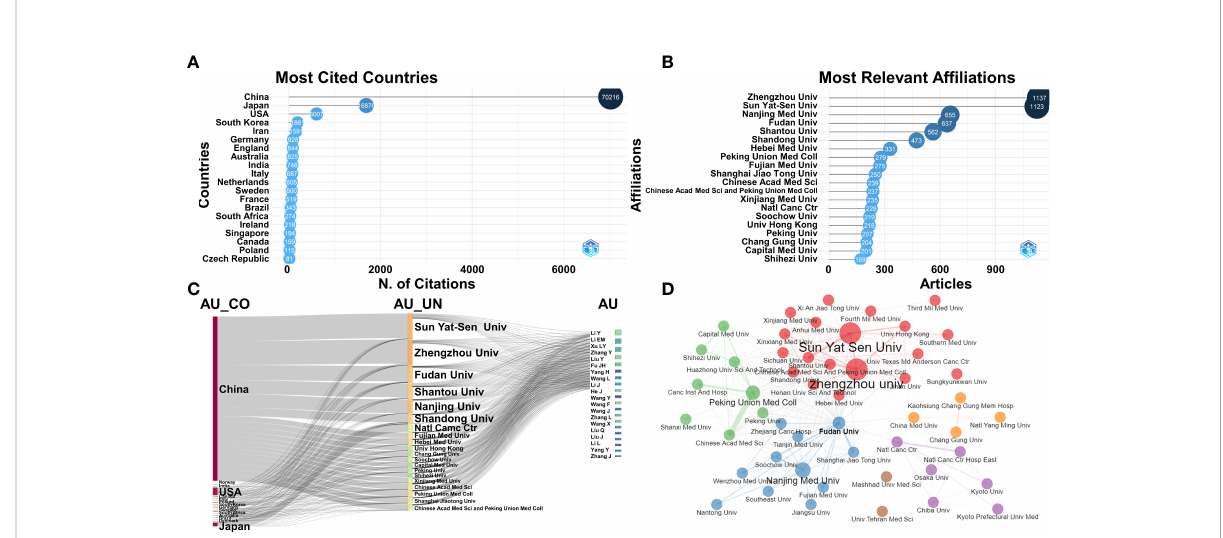
FIGURE 4 (A) Top 20 countries with the most global citations. (B) Top 20 institutions with the highest publication number. (C) Three- fi elds plot among countries (AU_CO), institutions (AU_UN), and authors (AU). (D) Network of institutional collaborations.